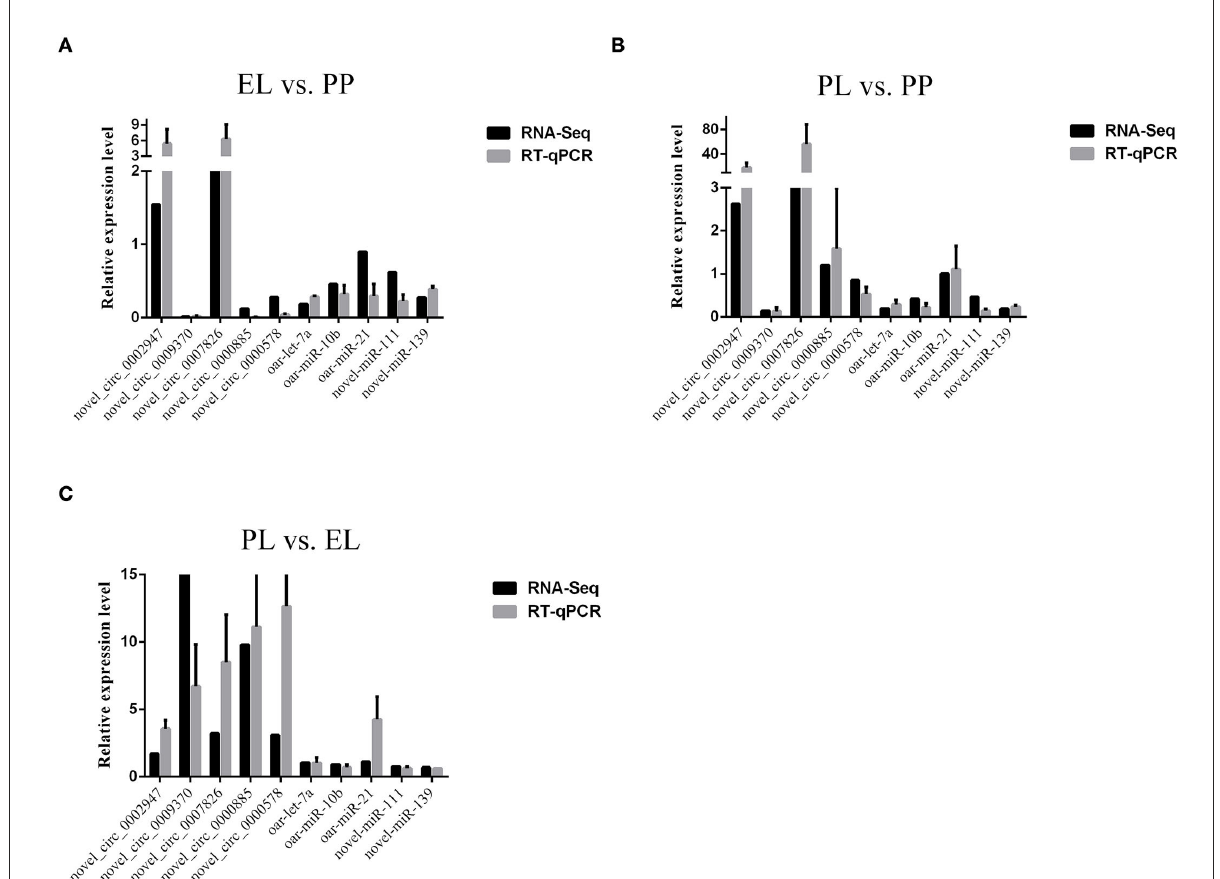
FIGURE10 Comparisons of the results of RNA-sequencing (RNA-seq) and quantitative PCR (qPCR) analyses of selected non-coding RNAs in the EL vs. PP (A) , PL vs. PP (B) , and PL vs. EL comparisons (C)